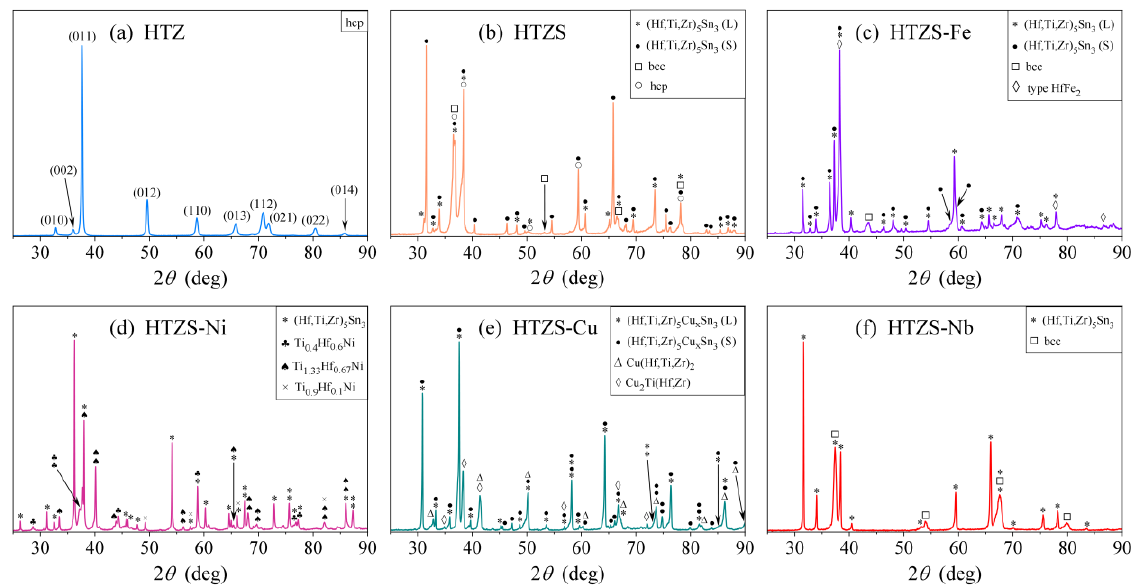
Figure 1. XRD patterns of the six investigated alloys: ( a ) HfTiZr (HTZ), ( b ) HfTiZrSn (HTZS), ( c ) HfTiZrSnFe (HTZS-Fe), ( d ) HfTiZrSnNi (HTZS-Ni), ( e ) HfTiZrSnCu (HTZS-Cu), ( f ) HfTiZrSnNb (HTZS-Nb). For details, see Table 3 and the text. The marks (L) and (S) in some of the legends denote larger and smaller unit cell.